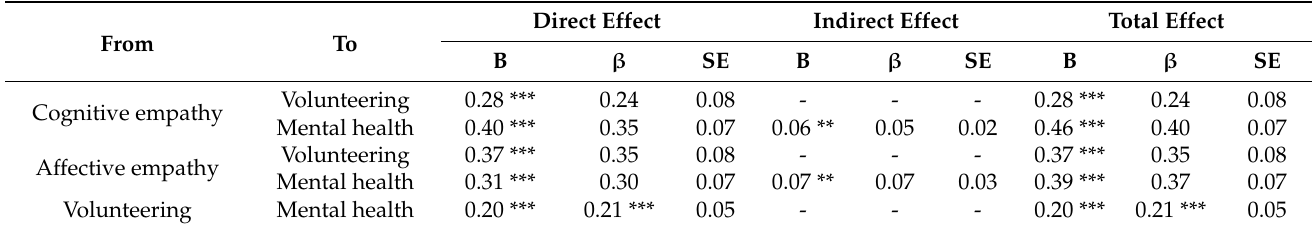
Table 3. Coefficients from the constrained model.